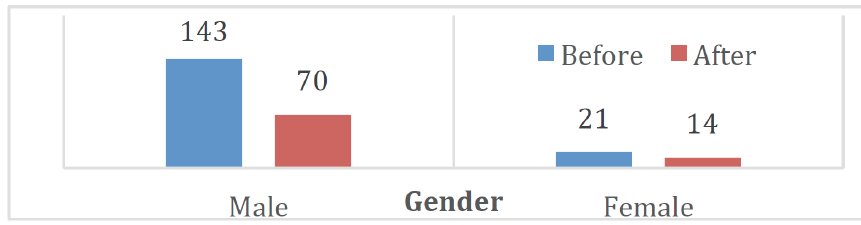
Fig. 1. Distribution of valid Pre and Post survey participants based on